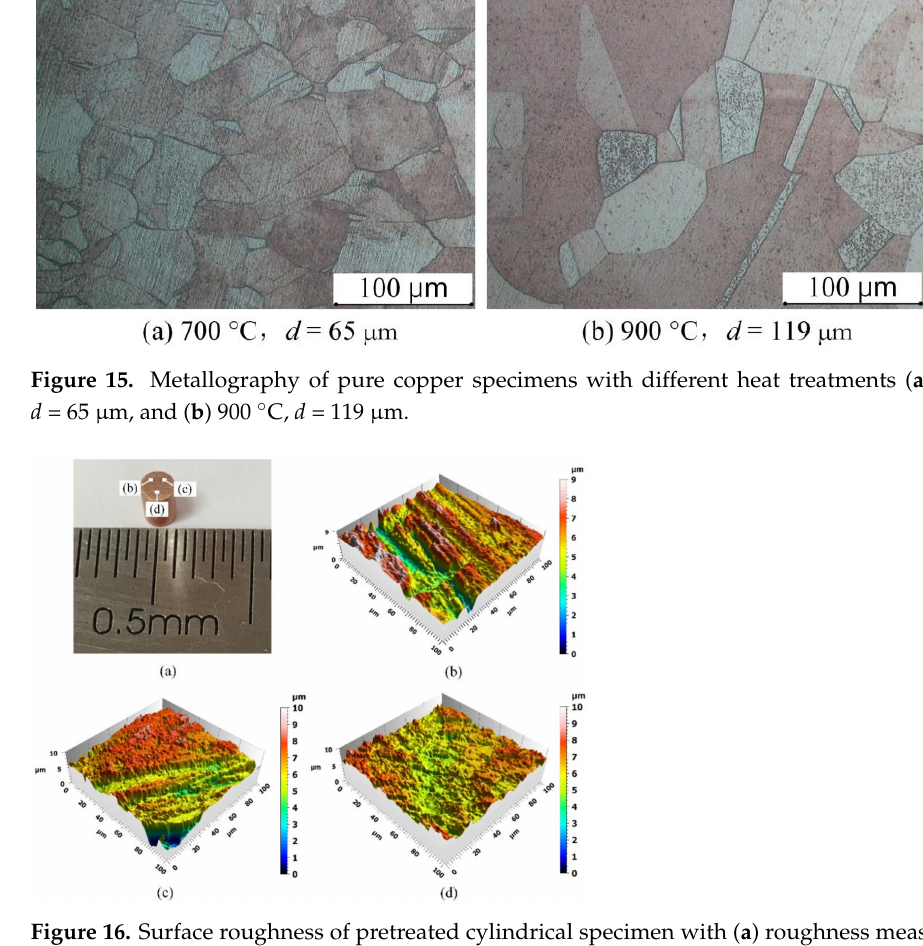
Figure 16. Surface roughness of pretreated cylindrical specimen with ( a ) roughness measurement positions as ( b ) S qin = 1.58 μm, ( c ) S qin = 1.56 μm , and ( d ) S qin = 1.57 μm.